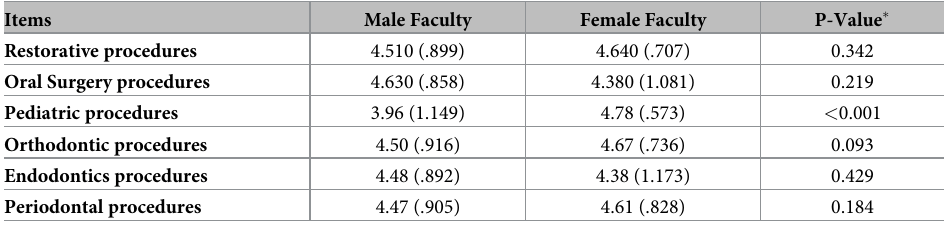
Table 5. Student’s mean (SD) preference scores of working with male or female faculty in different specialty